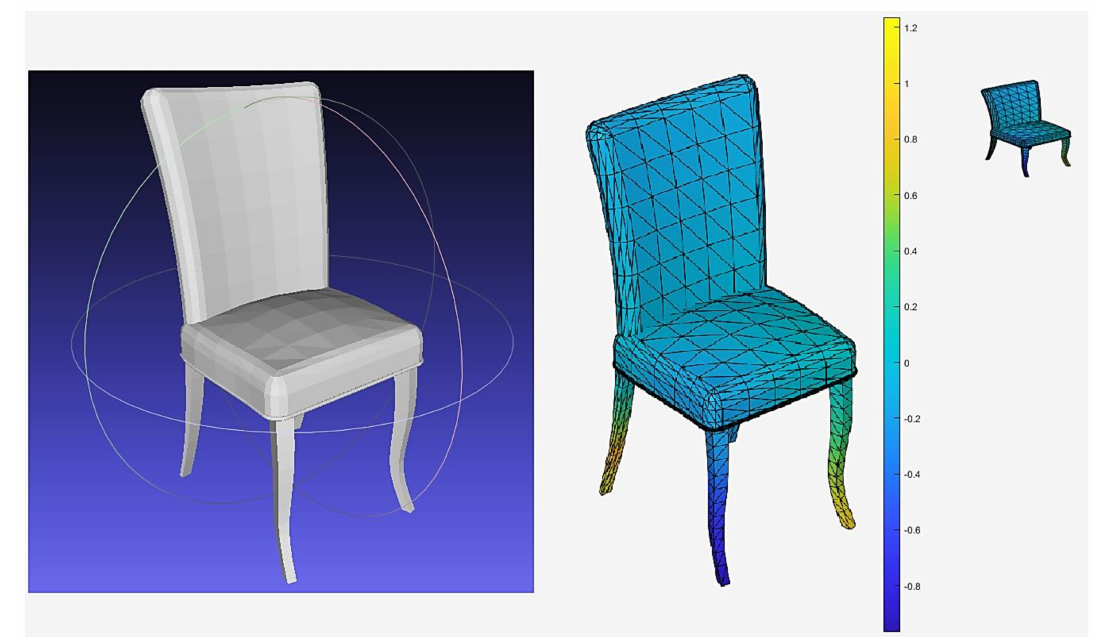
Figure 3. ( Left )—the original 3D chair. ( Right )—the 2D view 32 by 32 by 3. ( Middle )—the 3D color model using GPSPlus value.